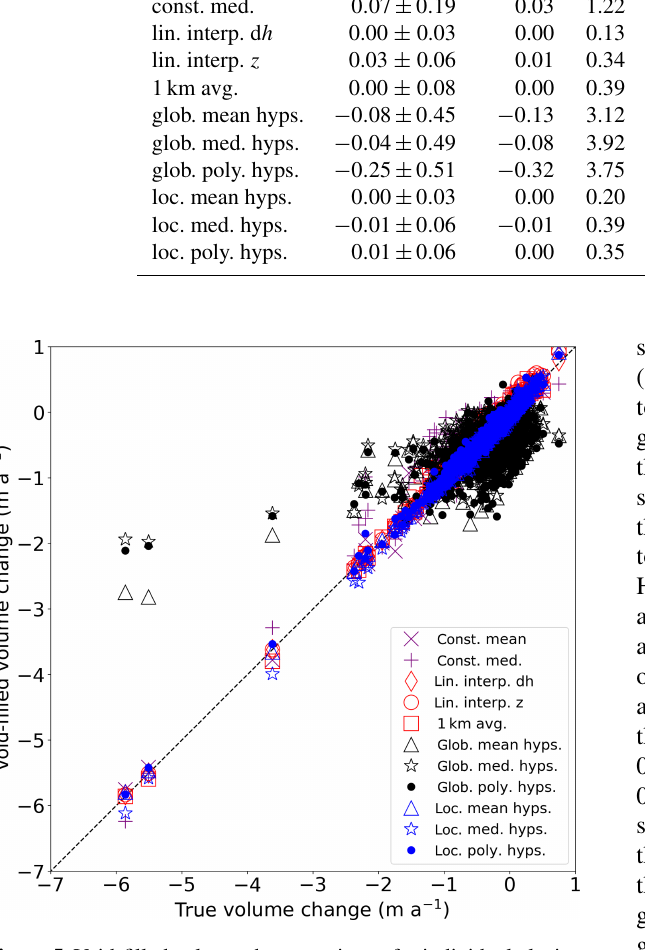
Figure 5. Void-filled volume change estimate for individual glaciers vs. true volume